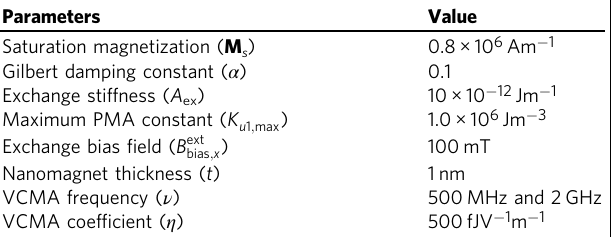
Table 1 List of parameters used in the